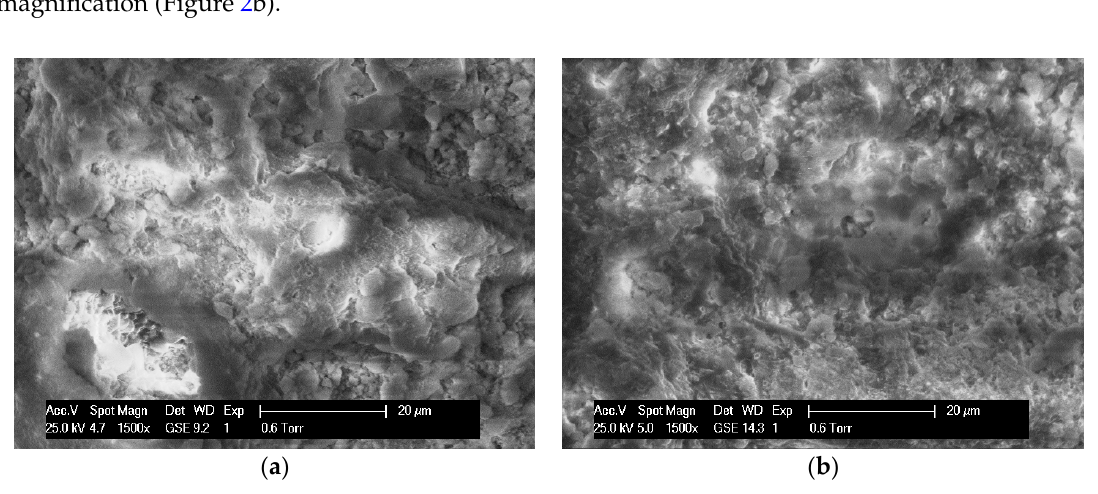
Figure 2. ESEM images: ( a ) Untreated stone surface; ( b ) Surface of T 2.5 .